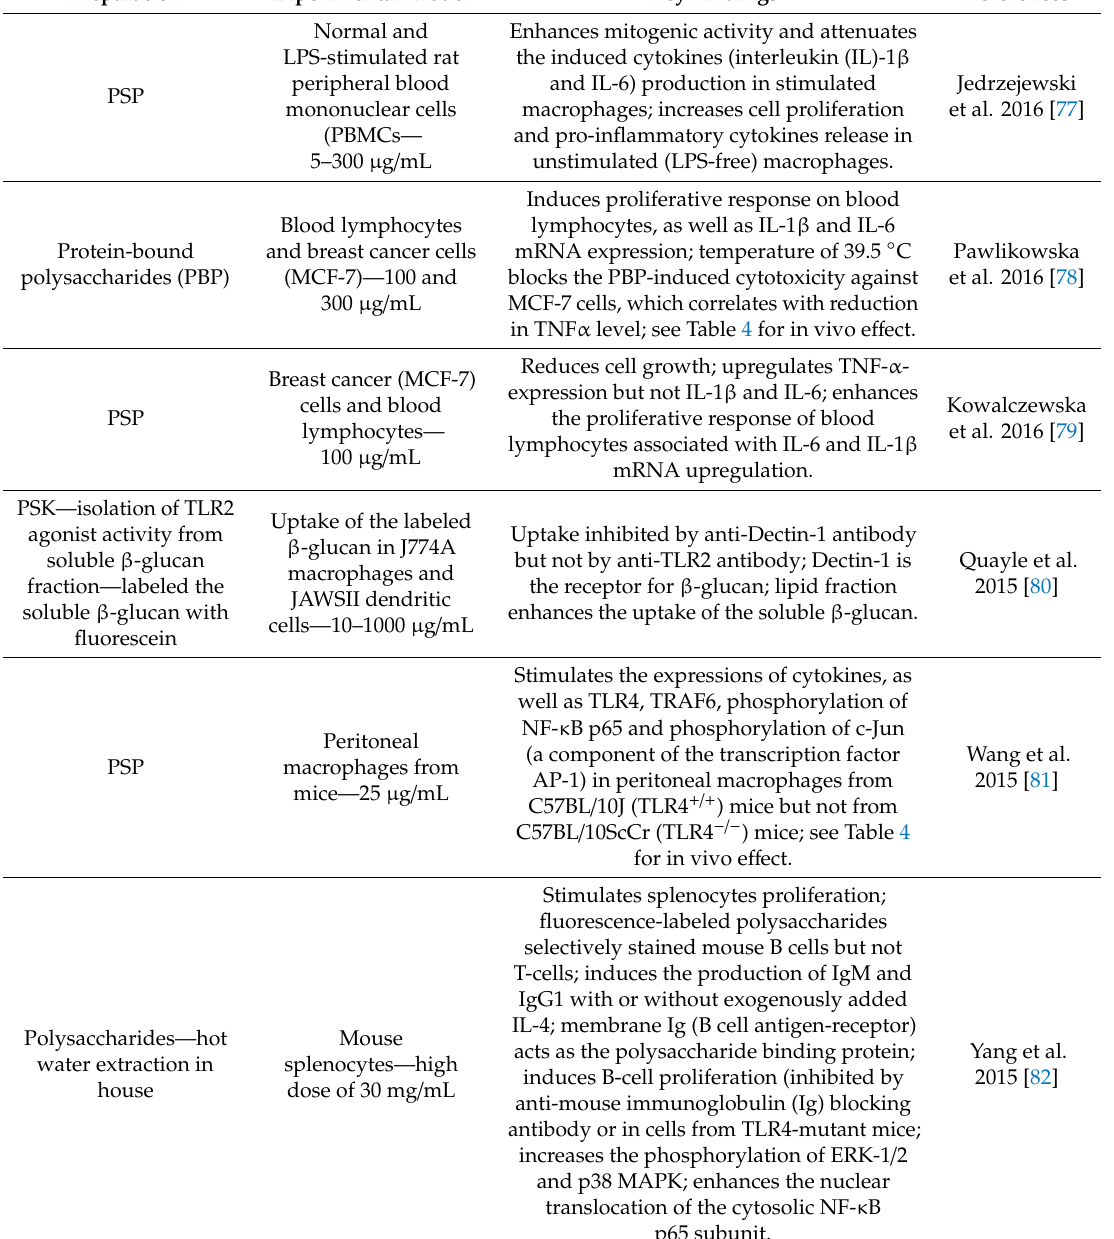
Table 3. Immunomodulatory e ff ects related to cancer: in vitro